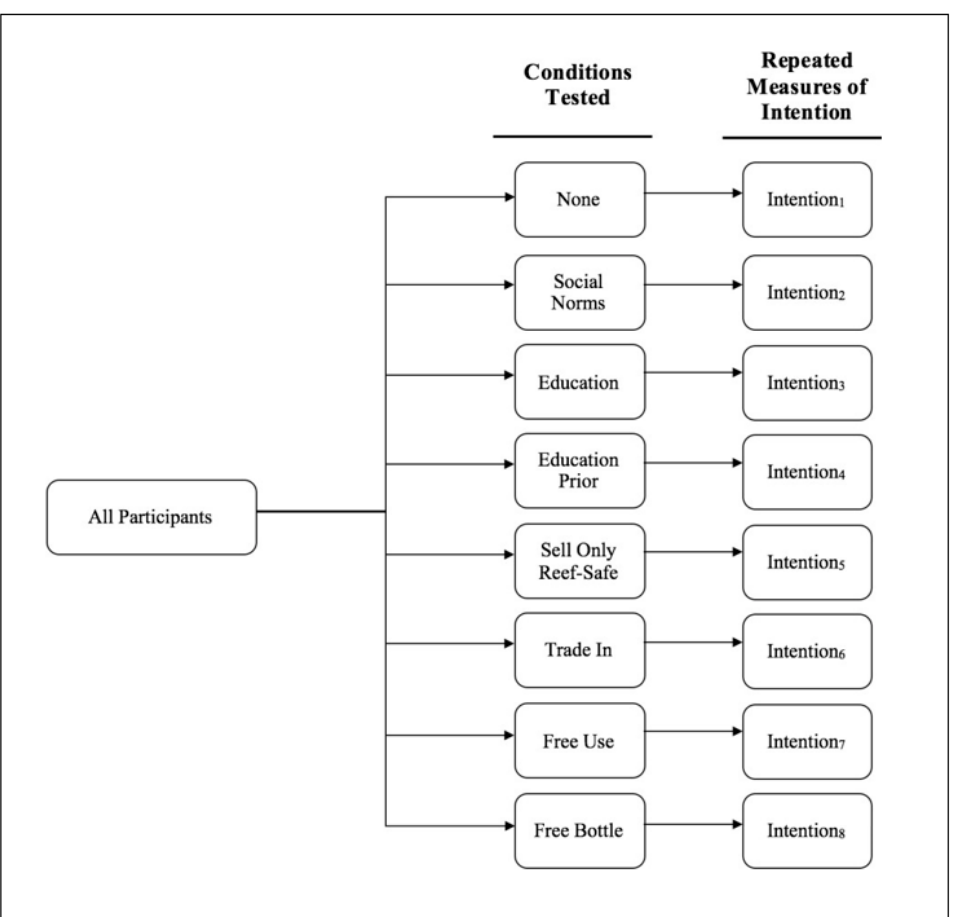
Figure 2. Proposed conceptual framework of pro-environmental behavior: Subset II. Experimental design testing influence of Contextual Factors on Intention.